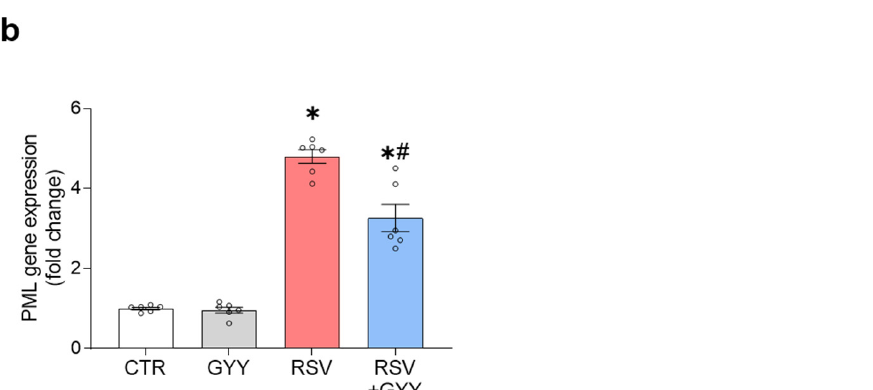
Figure 5. H 2 S donor GYY4137 downregulates PML in RSV infection. ( a ) SAECs uninfected and infected with RSV were treated with 5 mM GYY4137 or its vehicle. Cells were harvested 18 hpi with SDS loading buffer. Whole cell lysates (30 µ L) were analyzed by Western blot with anti-PML protein antibody. The membrane was reprobed for anti- β -actin antibody for loading control. Western blot images are one representative of three independent experiments. The graph shows the densitometric analysis of PML after normalization to β -actin expressed as mean ± SEM; ( b ) SAECs uninfected and infected with RSV were treated with 5 mM GYY4137 and harvested 18 hpi to prepare total RNA. PML gene expression was quantified by RT-qPCR. The graph shows combined data from two independent experiments expressed as mean ± SEM. The results were analyzed by two-way ANOVA followed by Tukey’s test (* p < 0.05 vs. CTR; # p < 0.05 vs. RSV).